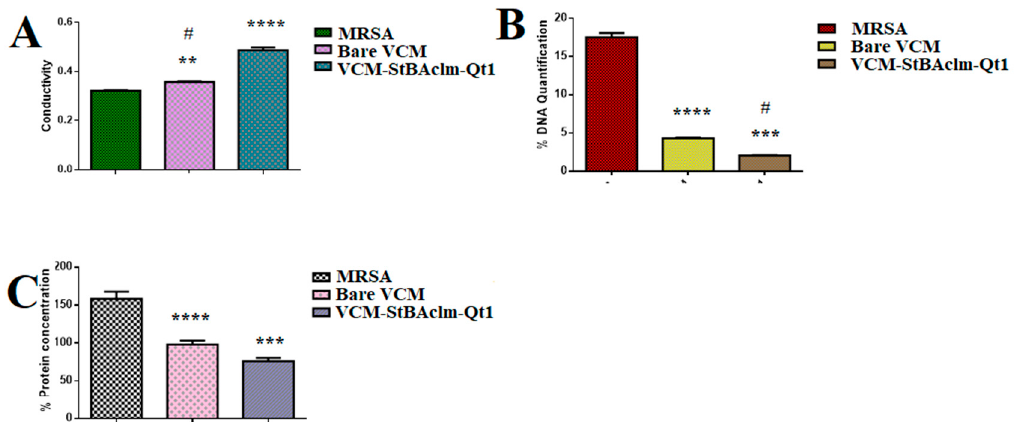
Figure 10. (A ) Electrical conductivity of bare VCM and VCM-loaded StBAclm-Qt1 quatsomes. ** denotes the statistical significance of bare VCM compared to MRSA (control). **** denotes the statistical significance of bare VCM compared to VCM-loaded StBAclm-Qt1 quatsomes, and # denotes the comparison of VCM-loaded StBAclm-Qt1 quatsomes and MRSA (control); ( B ) reduction of DNA quantification of bare VCM and VCM-loaded StBAclm-Qt1 quatsomes. **** denotes the statistical significance of bare VCM compared to MRSA (control). *** denotes the statistical significance of bare VCM compared to VCM-loaded StBAclm-Qt1 quatsomes, and # denotes the comparison of VCM-loaded StBAclm-Qt1 quatsomes and MRSA (control); ( C ) reduction of protein quantification: bare VCM and VCM-loaded StBAclm-Qt1 quatsomes. **** denotes the statistical significance of bare VCM compared to MRSA (control). *** denotes the statistical significance of bare VCM compared to VCM-loaded StBAclm-Qt1 quatsomes.